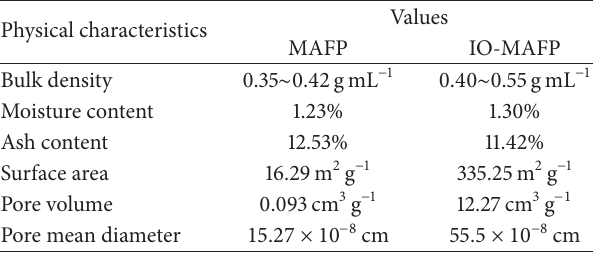
Table 1: Physical characteristics of MAFP and IO-MAFP biosor-